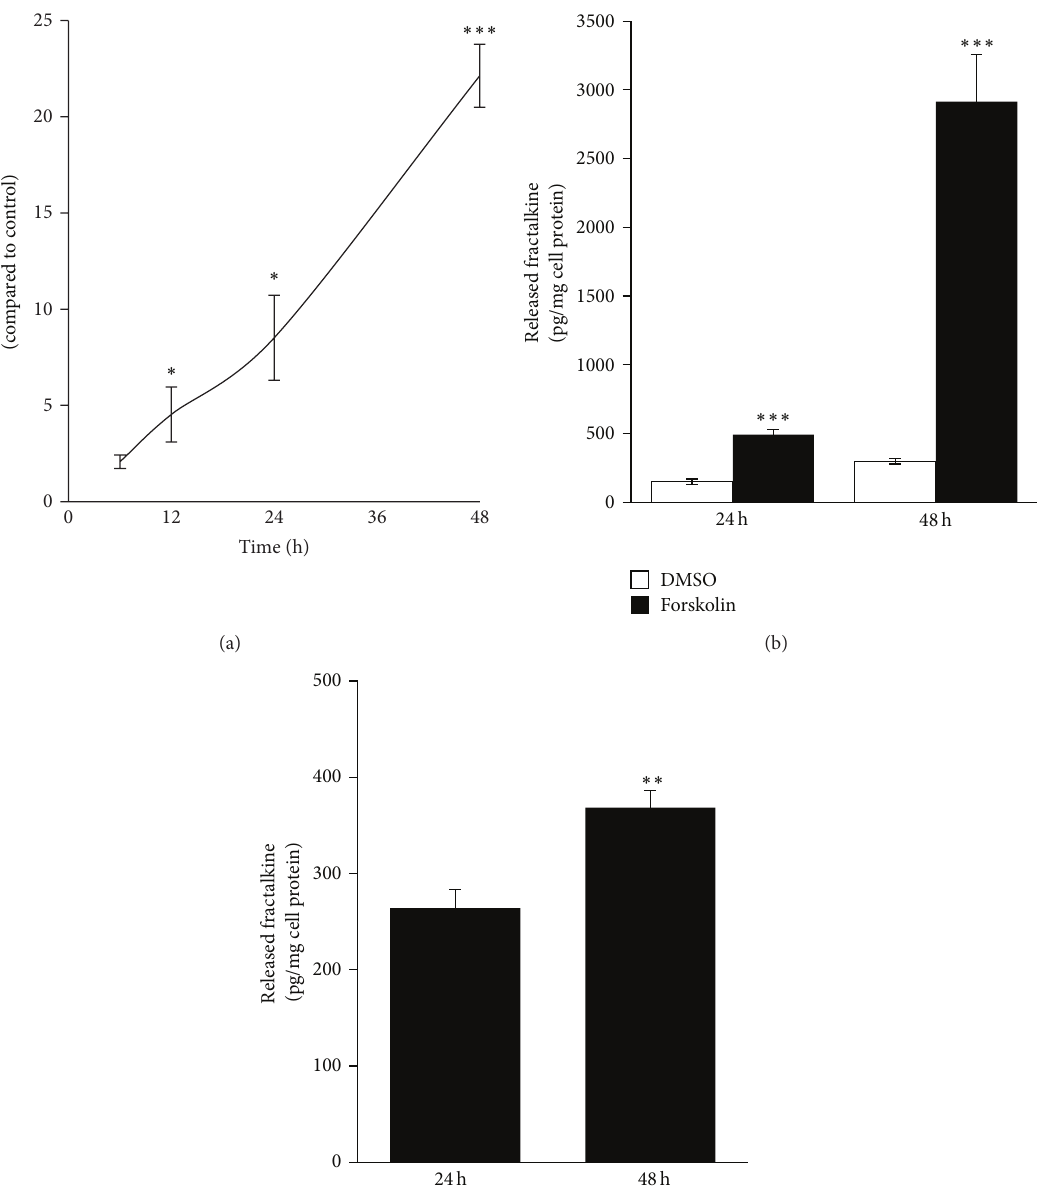
agreement with increasing expression and release of placental fractalkine towards